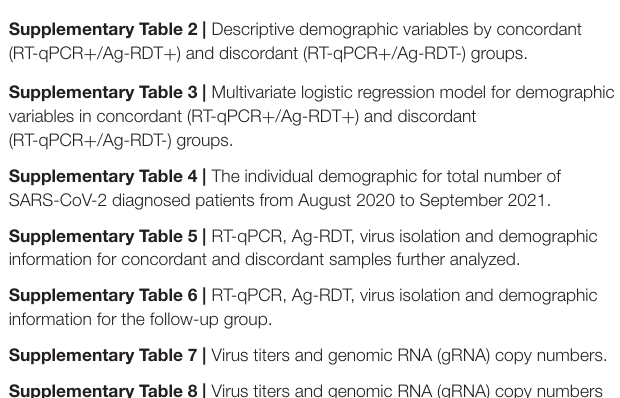
Supplementary Table 3 | Multivariate logistic regression model for demographic variables in concordant (RT-qPCR + /Ag-RDT + ) and discordant (RT-qPCR + /Ag-RDT-) groups.